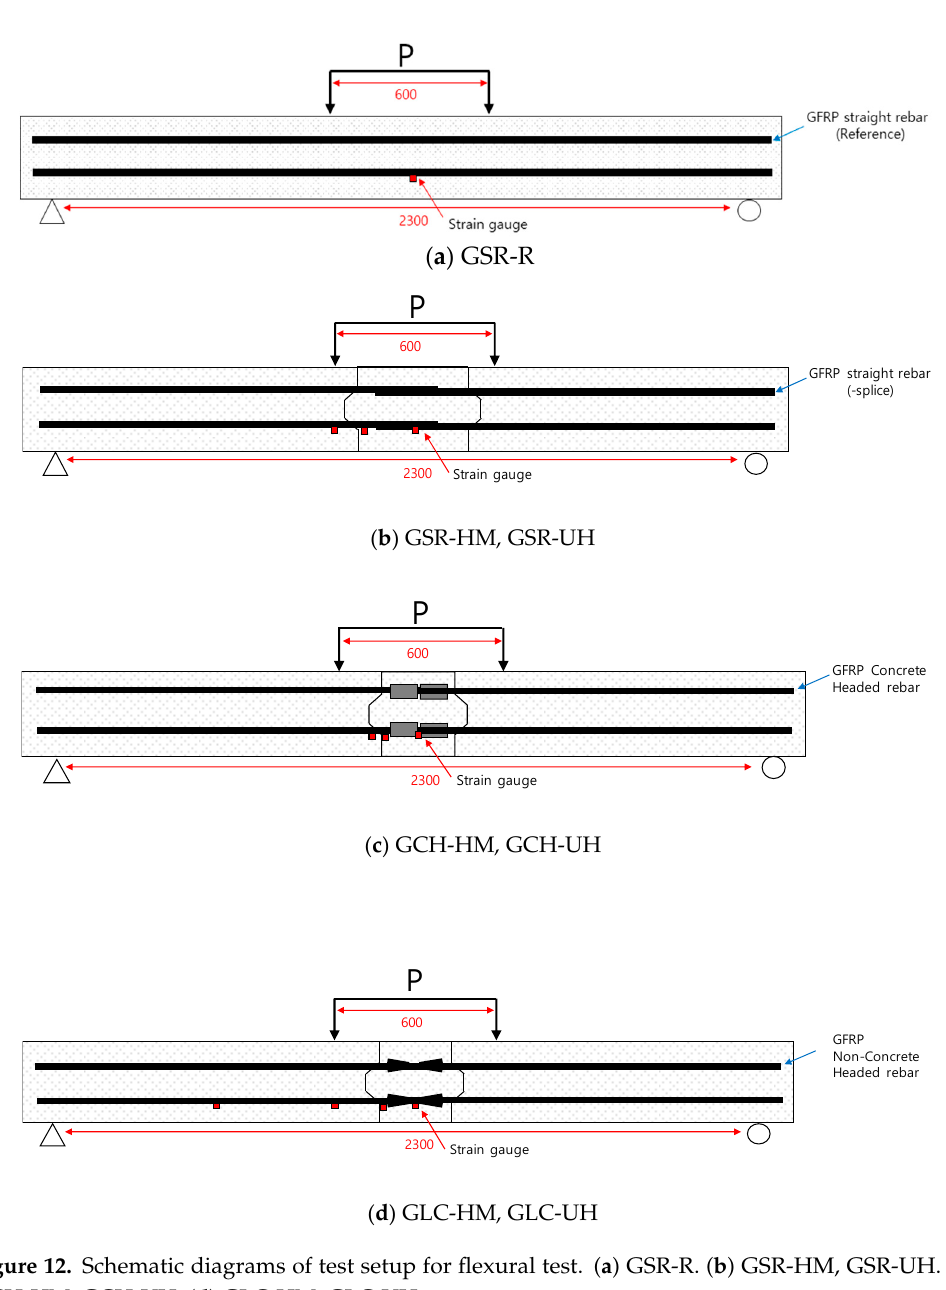
GCH-HM, GCH-UH. ( d ) GLC-HM, GCH-UH. ( d ) GLC-HM, GLC-UH.